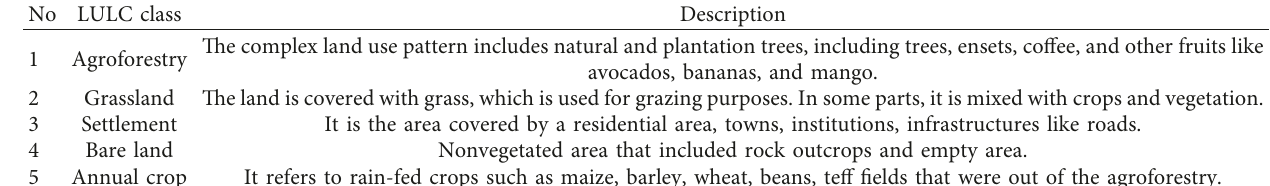
Figure 8: Agroecological zone of the study Table 2: The description of the land use class in 2018.